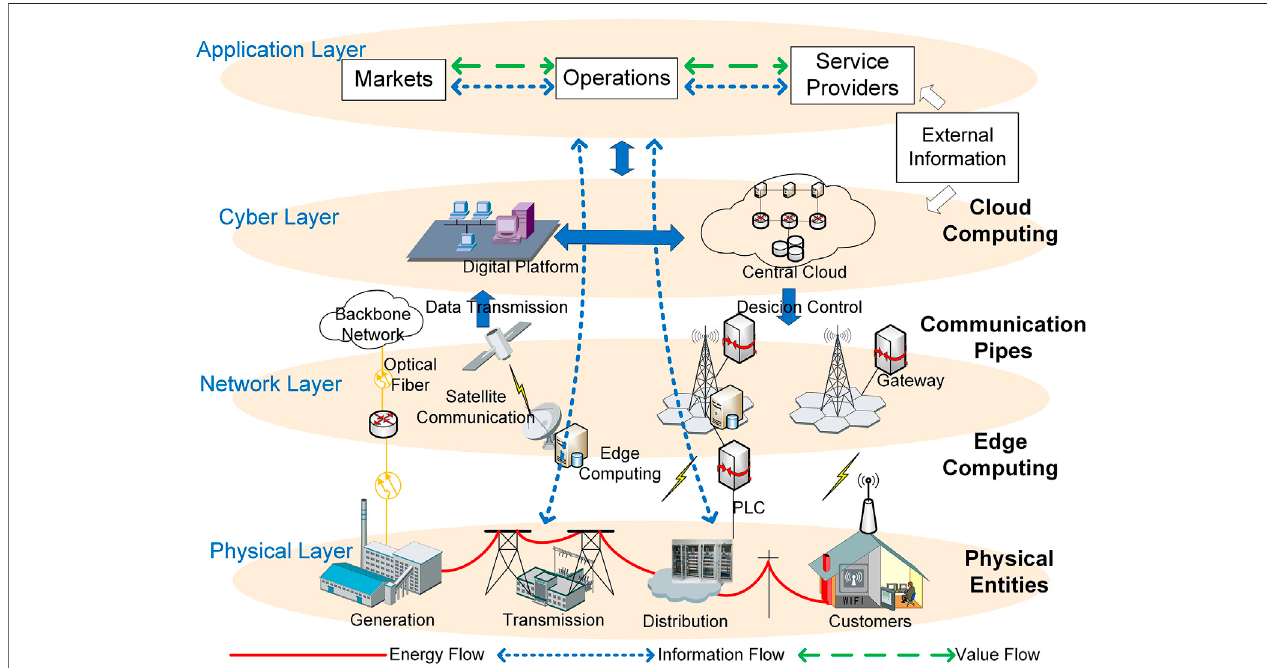
FIGURE 5 | Layered architecture and enabling technologies of the